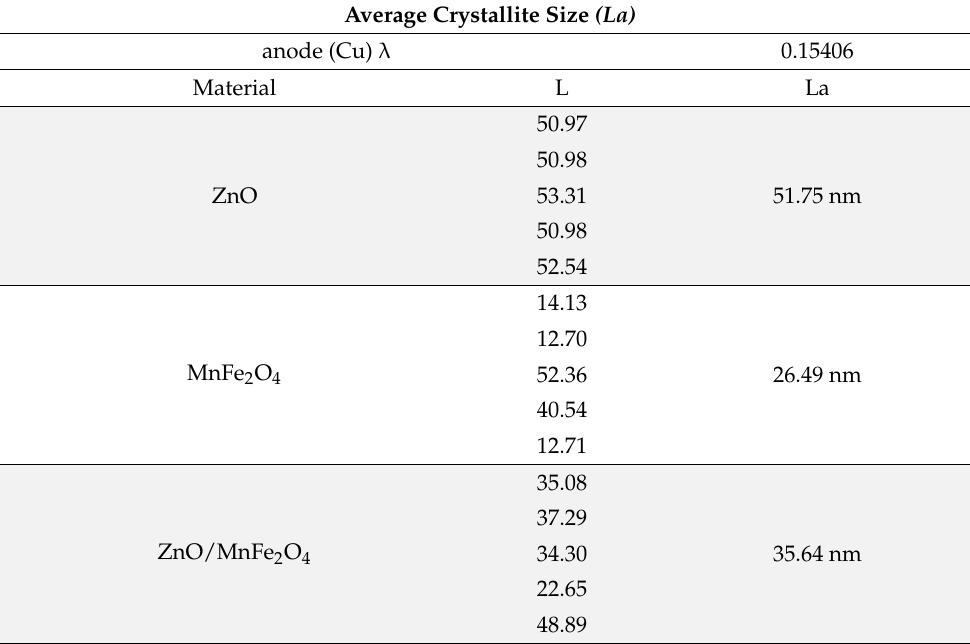
Table 2. Average crystallite size of the synthesized materials. Average Crystallite Size